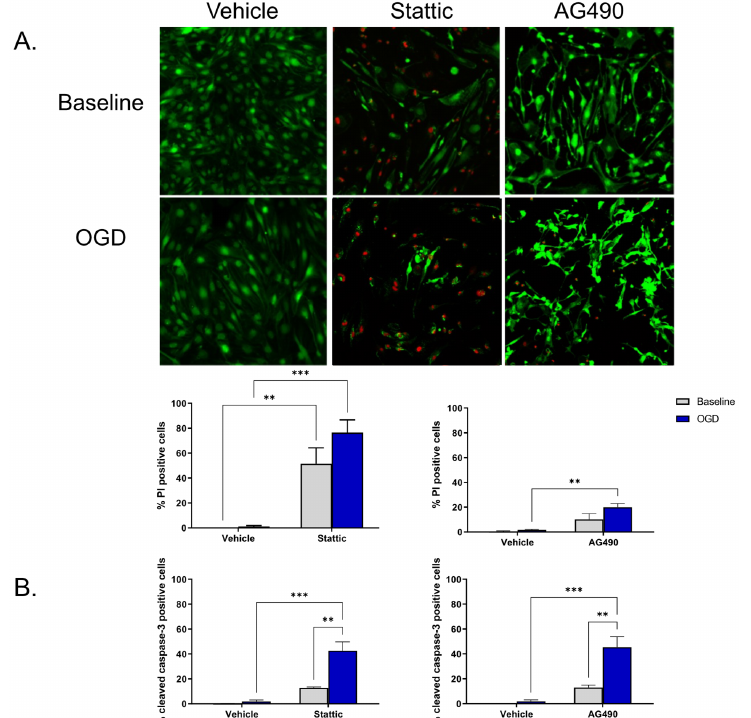
Figure 2. Inhibition of STAT3 causes endothelial cell death. Cells were incubated with STAT3 inhib- itors, Stattic (10 μ M) or AG490 (1mM), for 24 h at baseline (no-OGD) or following 8 h OGD.